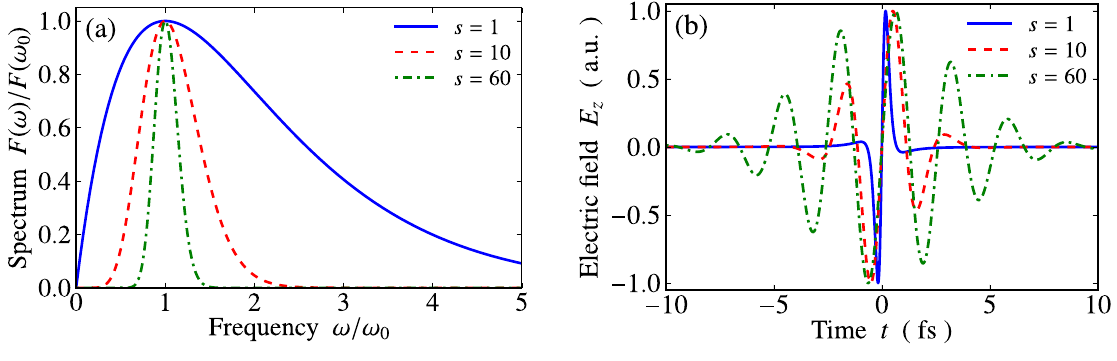
Figure 5. ( a ) Poisson spectrum F ( ω ) for different values of s with φ profile of the on-axis longitudinal electric field component at z = 0 of the corresponding TM pulsed beam with λ 01